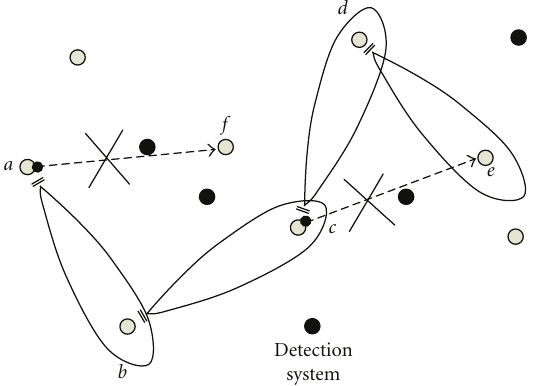
Figure 8: An illustration of anonymous routing using directional antennas.